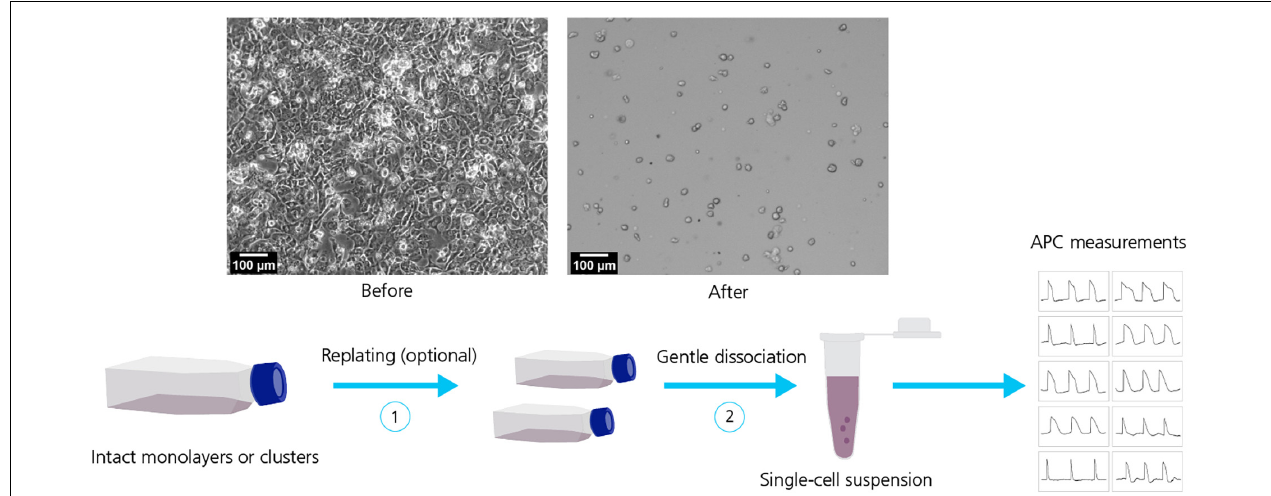
FIGURE 3 | Dissociation of hiPSC-derived cell lines. Top row: Micrographs of hiPSC-CMs before (left) and after (right) dissociation. Bottom row: Dissociation of hiPSC-derived cell lines typically include a sequence of steps for example replating (1) followed by gentle dissociation methods (2) to obtain a homogeneous, healthy single-cell suspension suitable for APC measurements. Adapted from Rajamohan et al. (2016), with permission under Creative Commons Attributions License (CC